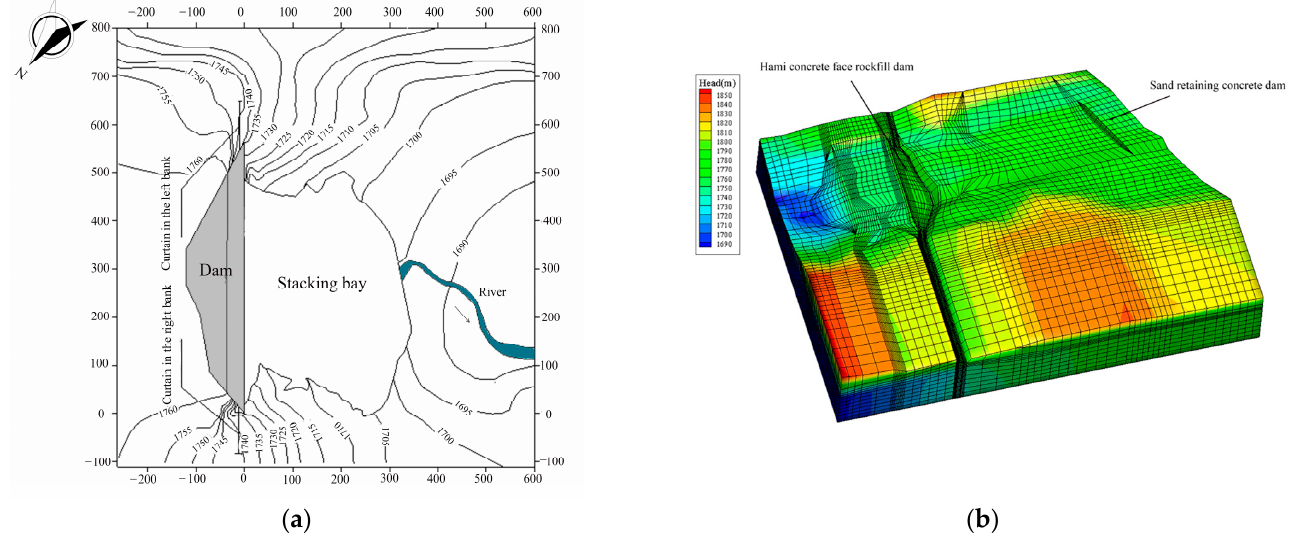
Figure 11. Results of the Hami concrete-face rockfill dam’s three-dimensional seepage field calcula- tion. ( a ) Contour map of the groundwater level of the Hami concrete-face rockfill dam under HM-1. ( b ) Three-dimensional seepage field of the Hami concrete-face rockfill dam under HM-1.